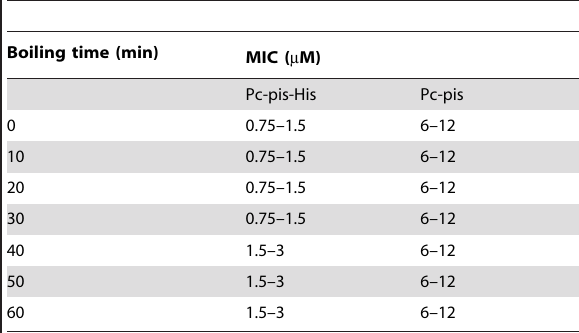
Table 4. Effect of heat treatment on activity of Pc-pis-His and Pc-pis against S. aureus